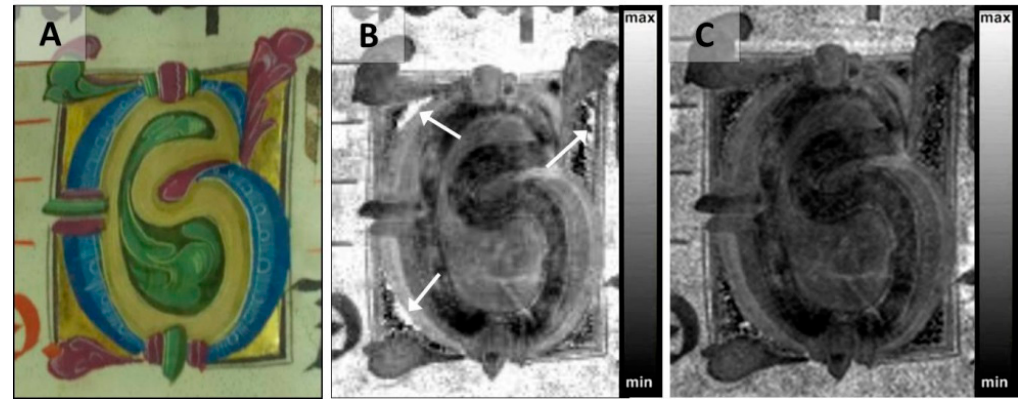
Figure 10. Antiphonary, XV century, Biblioteca Angelica of Rome. ( A ) Photograph of the illuminated letter of folio 142 recto ; ( B ) thermogram before the restoration showing the detachment of the gold leaf from its substrate, indicated by the arrows; ( C ) thermogram after the restoration [51].